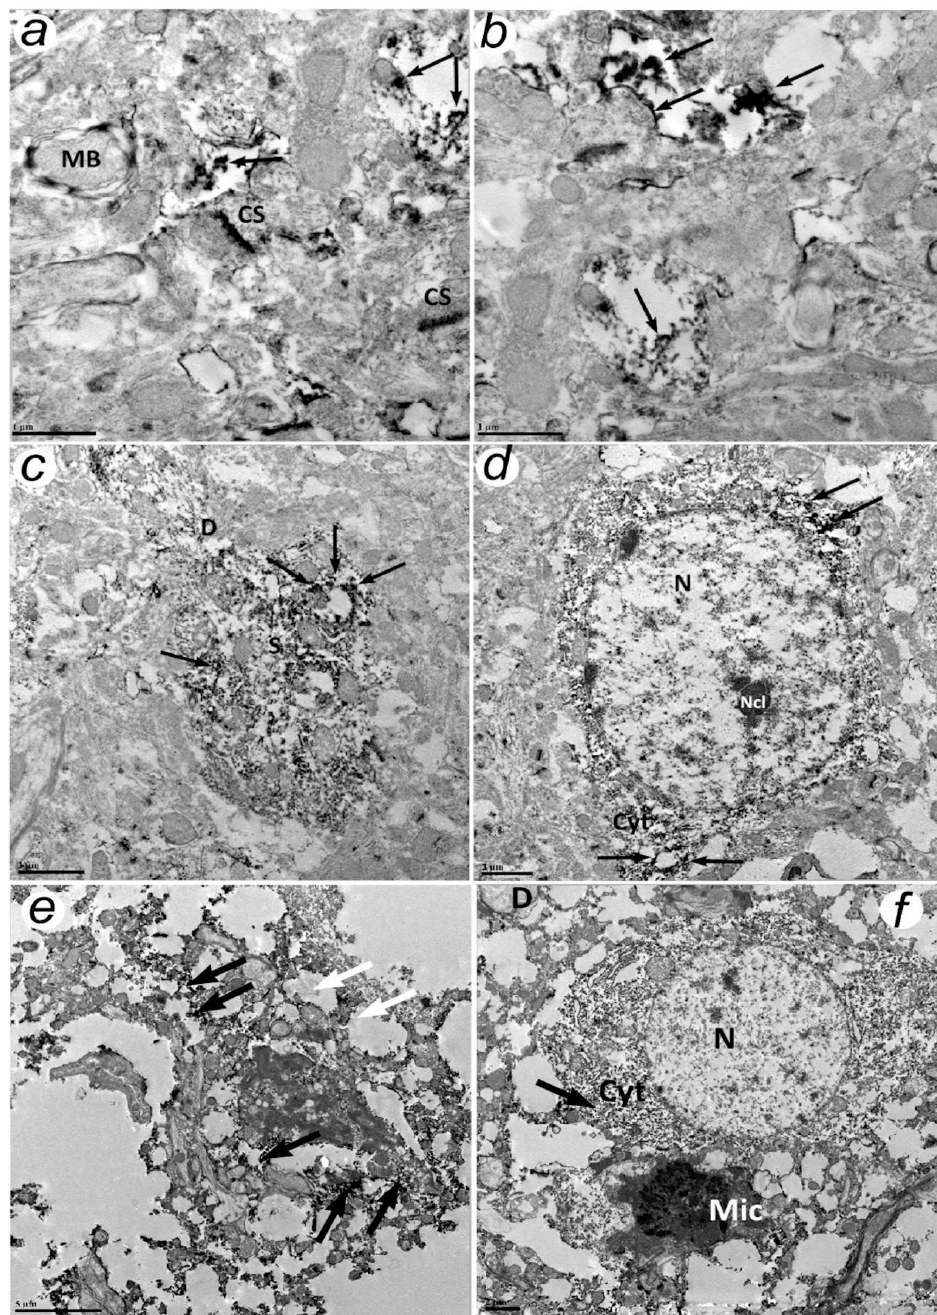
Figure 2. Electron immunohistochemistry with antibodies to C- and N-terminal fragments of APP protein in rat brain neocortex of the control group ( a , b ) and 4 h ( c , d ) or 24 h ( e , f ) after photothrombotic stroke. ( a ) Localization of APP (C-terminal domain): the medium amount of protein associated with cellular elements. ( b ) Localization of APP (N-terminal domain): filling of individual cell processes with APP. ( c ) APP (N-terminal domain) localization: numerous processes containing APP fragments. ( d ) APP (N-terminal domain) localization in neuronal cytoplasm. ( e ) The destruction of the neuropil, lysis of the cytoplasm of the cell and processes. ( f ) A neuron containing the APP and an APP-negative microglial cell. Legend: CS—chemical synapse, MB—myelin branch, S—neuronal soma, D—dendrite, N—nucleus, Ncl—nucleolus, Cyt—cytoplasm, Mic—microglia, the products of the reaction are indicated by arrows. Magnification: a and b × 10,000 (Scale bar 5 µ m); c,d,f × 20,000 (Scale bar 2 µ m); e × 50,000 (Scale bar 1 µ